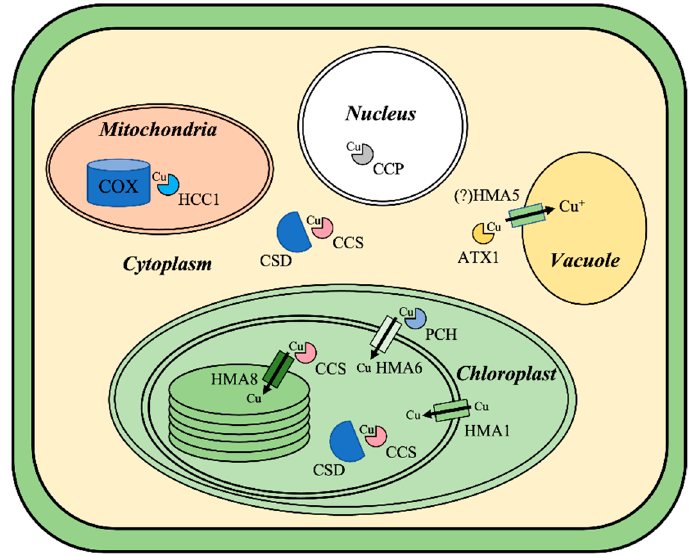
Figure 3. Copper chaperones in Arabidopsis thaliana and their roles in Cu homeostasis . An A. thaliana cell is represented with all organelles for which Cu chaperones are described. In the chloroplast, inner envelope and thylakoid membrane transporters are shown. AtPCH is the Cu chaperone to AtHMA6, and AtCCS is chaperone to AtHMA8, as well as to stroma localized CuZnSOD (CSD). AtCCS is the chaperone to CSD localized in the cytoplasm. AtATX1 is shown as the Cu chaperone to AtHMA5 (for simplification, AtHMA5 is shown only in the tonoplast but not at the plasma membrane). AtHCC1 is the Cu chaperone likely delivering Cu to mitochondrial COX complex. AtCCP is a Cu chaperone important for plant immunity which localizes to the nucleus, but its interactions and specific role in Cu homeostasis is still unknown.